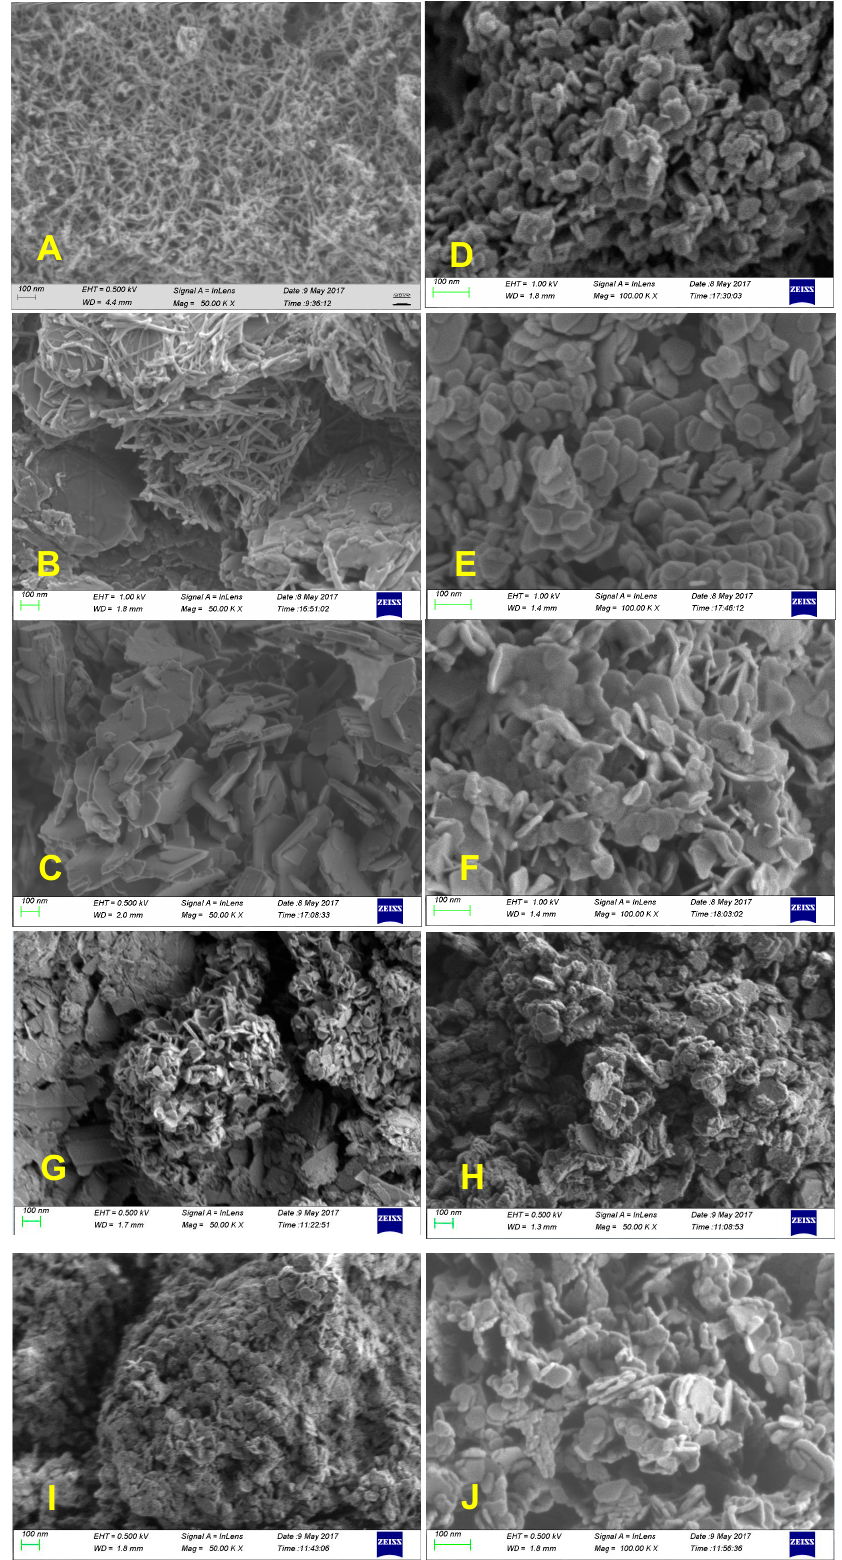
Figure 2. FE–SEM photographs of the prepared HTLCs: ( A ) 1:1; ( B ) 2:1; ( C ) 3:1 Cu/Al–HTLCs; ( D ) 1:1; ( E ) 2:1; ( F ) 3:1 Co/Al–HTLCs; ( G ) 1:1:1; ( H ) 1:1:2; ( I ) 1:2:1; ( J ) 2:1:1 Cu/Co/Al–HTLCs. To verify the possible functional groups, FT–IR analysis was performed for HTLCs of various compositions. In the case of Cu/Al–HTLCs, typical FT–IR spectra were recorded for the Cu:Al molar ratios of 1:1, 2:1 and 3:1 as shown in Figure 3A. The band near 3430 cm − 1 was assigned to the stretching